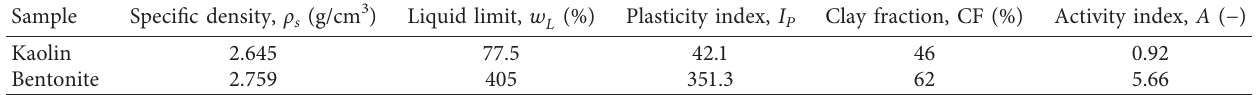
Table 1: Physical properties of kaolin and bentonite.